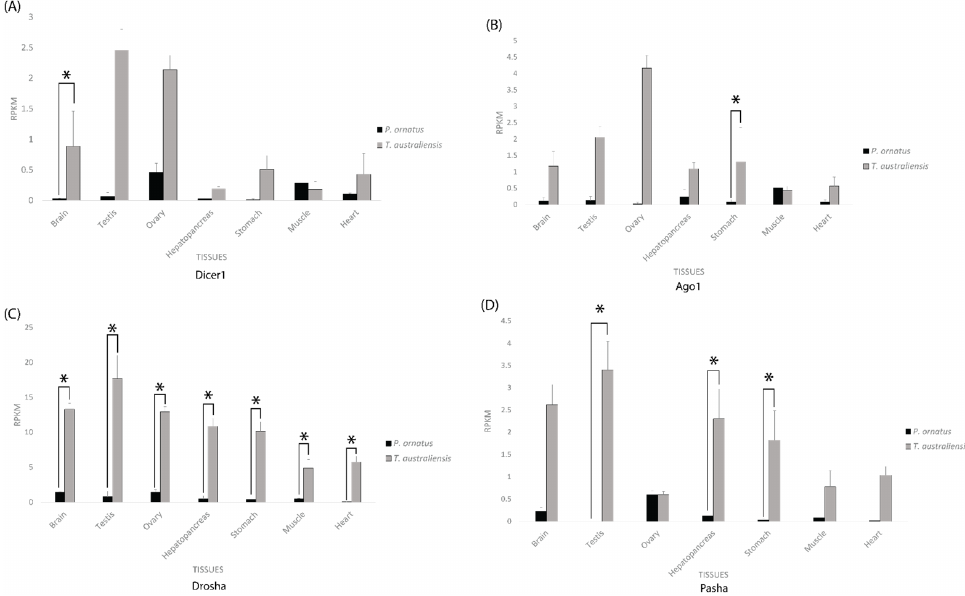
Figure 4. Expression of micro RNA (miRNA) pathway genes across adult tissues in Panulirus ornatus (n = 3) and Thenus australiensis (n = 3). Genes include Dicer 1 ( A ), Argonaute 1 ( B ), Drosha ( C ), and Pasha ( D ). Expression of genes is measured in reads per kilobase per million reads (RPKM). A black bar represents tissues from P. ornatus , and a grey bar represents tissues from T. australiensis . Tissues from left to right include brain, testis, ovary, hepatopancreas, stomach, muscle, and heart. An asterisk represents a statistically significant ( p < 0.05) difference in expression. Int. J. Mol. Sci. 2022 , 23 , x FOR PEER REVIEW